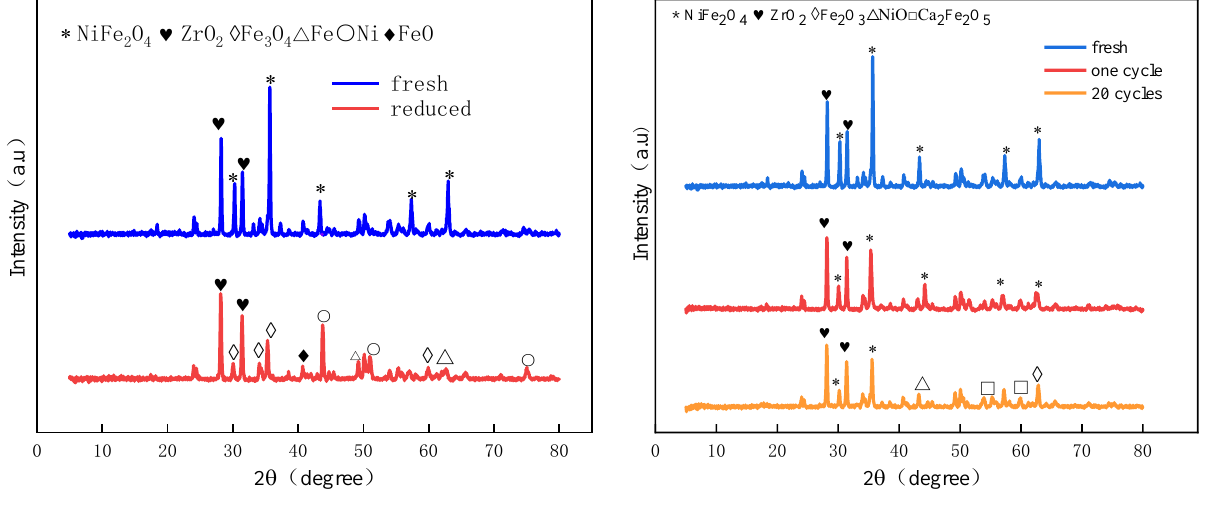
Figure 9. XRD patterns of fresh, reduced, 1 cycle, and 20 cycles.